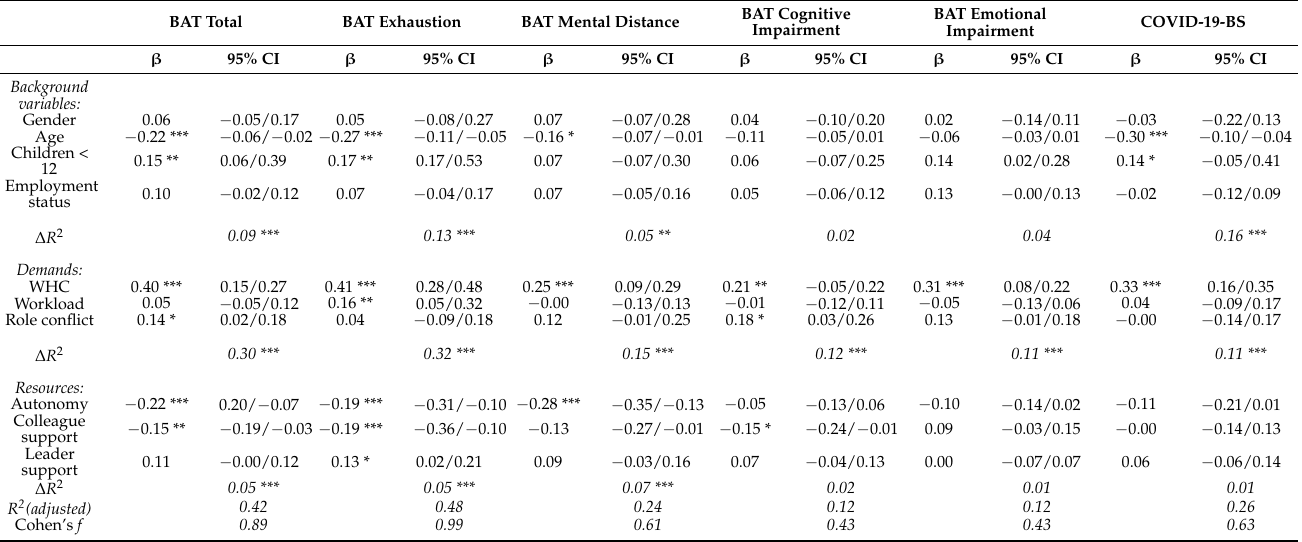
Table 2. Linear regression analyses for the organizational factors on the different burnout measures (BAT and